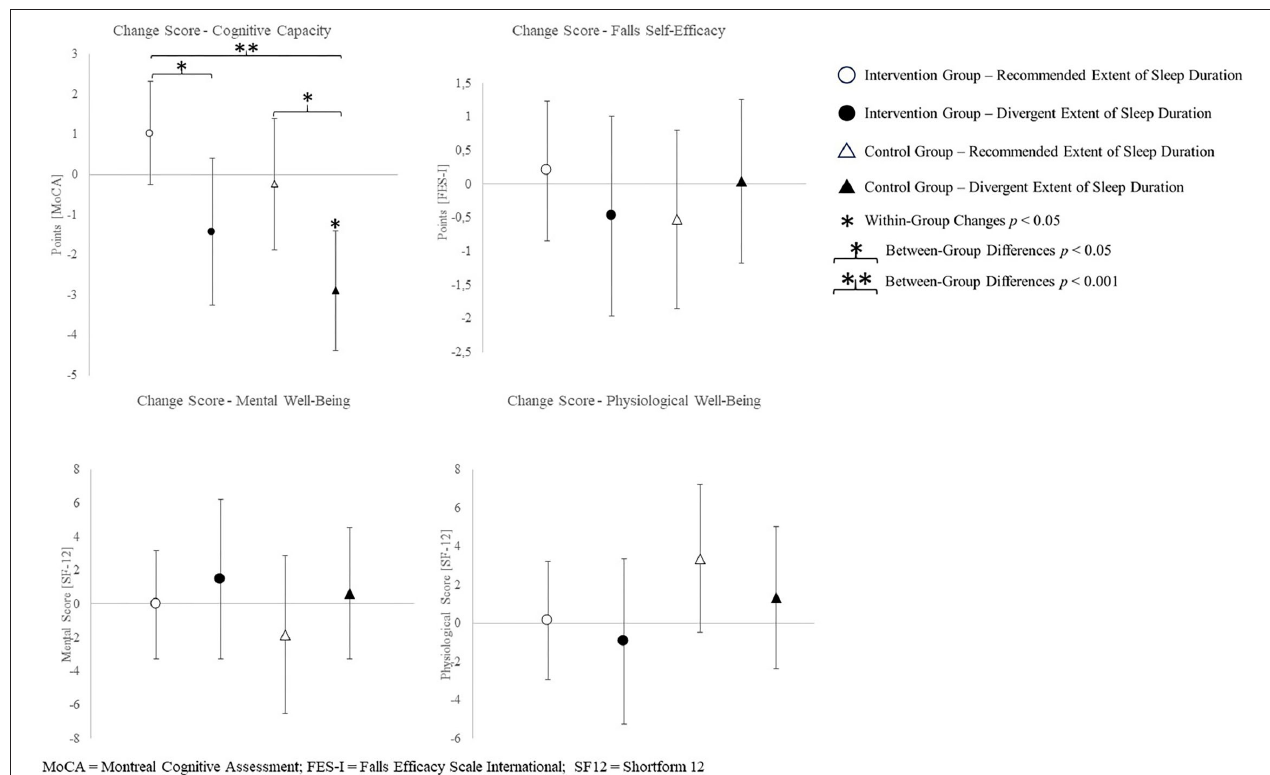
FIGURE 2 | Change scores of the primary outcome cognitive capacity, measured by the Montreal cognitive assessment and secondary outcomes fear of falling and health-related quality of life.